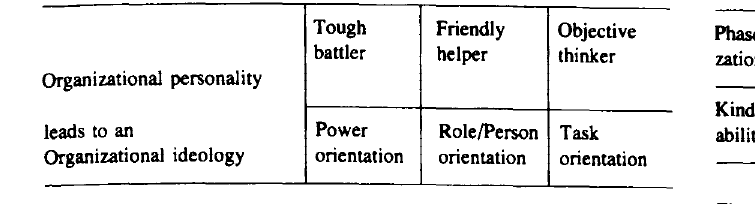
Fig. 3 Interrelationships between the organization's personality and its manifest